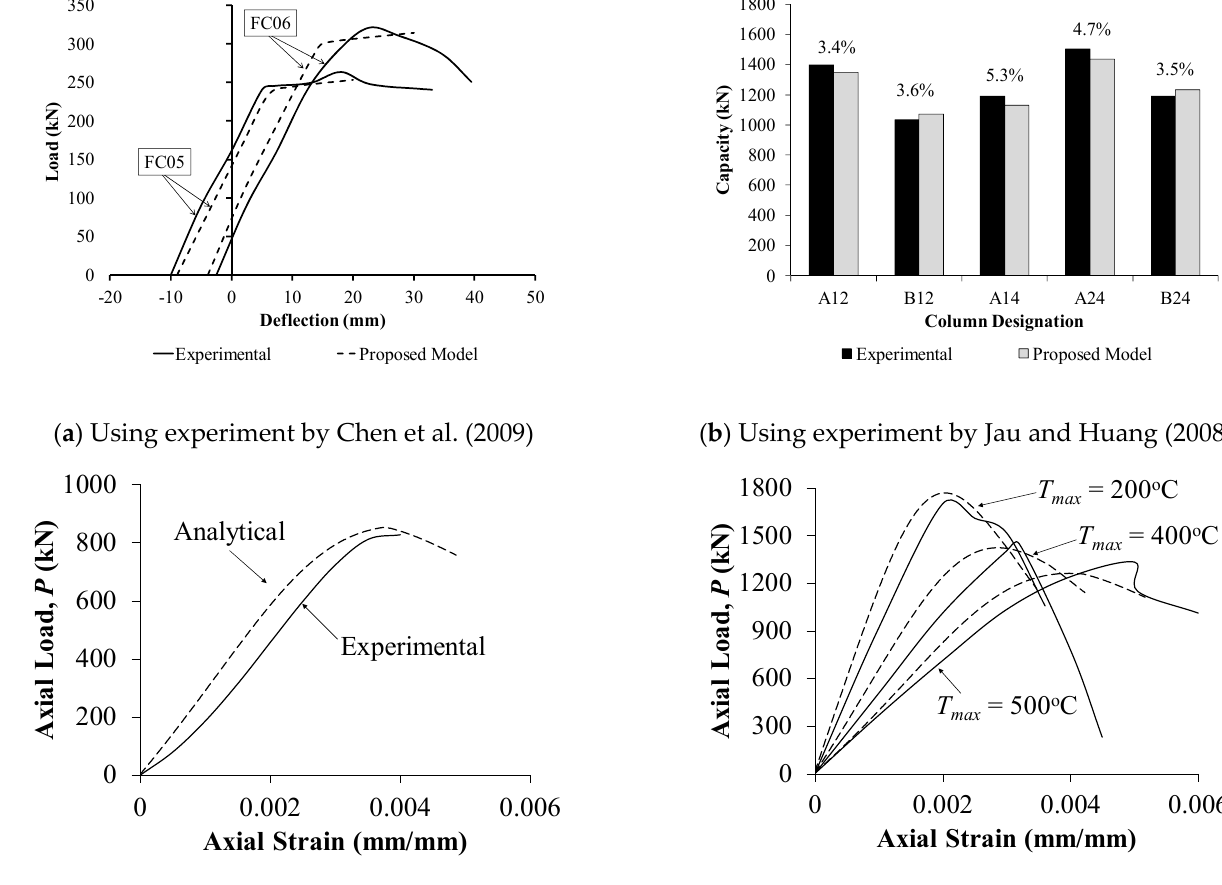
Figure 12. Validation of the proposed analytical model.